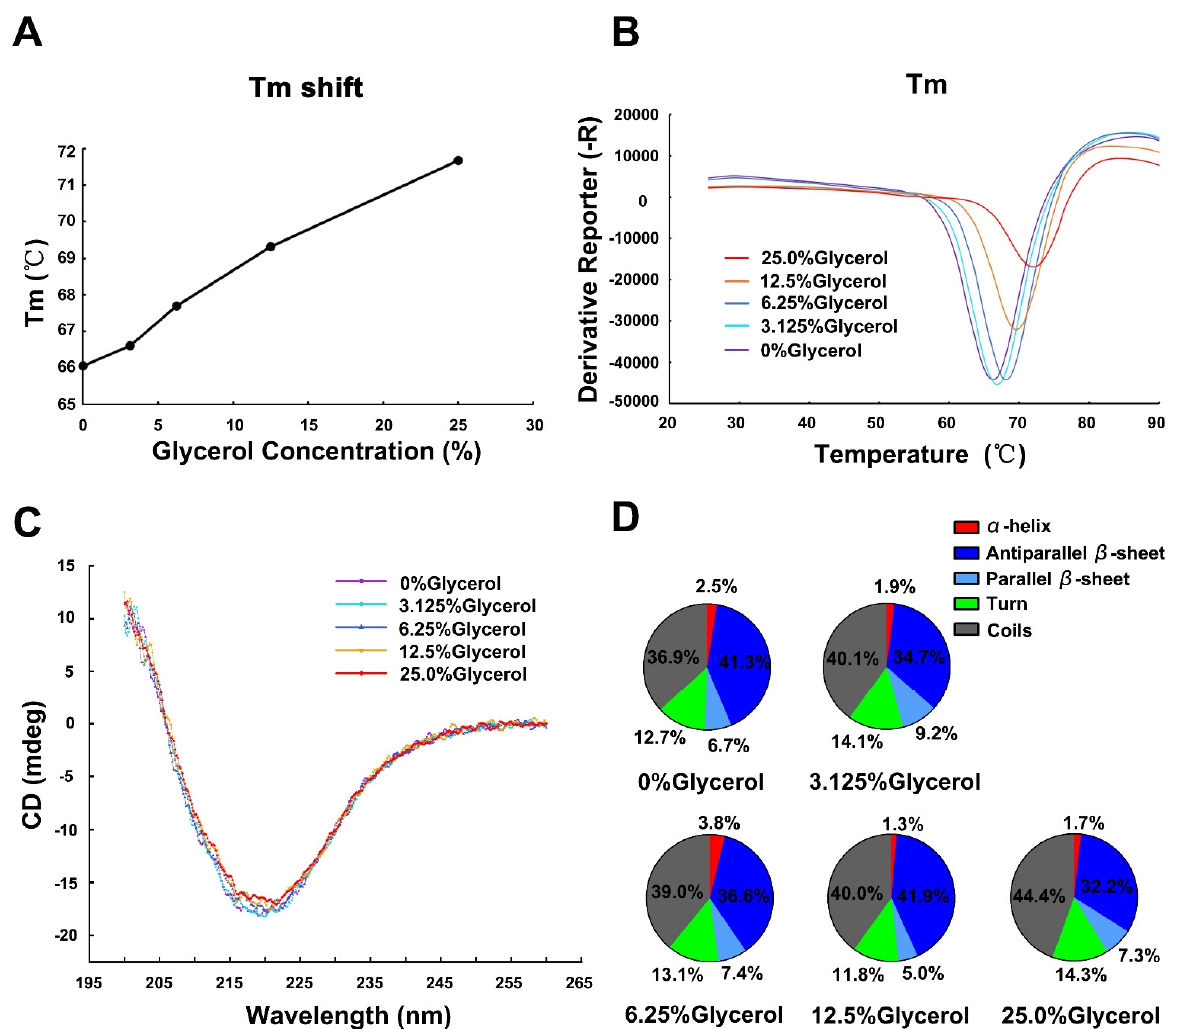
Figure 1. Thermal stability and secondary structural characteristics of Gal-7 in glycerol solutions. ( A ) Thermal shift assay. Tm shift when Gal-7 is incubated with different concentrations of glycerol. ( B ) Glycerol increases the melting temperature of Gal-7, indicating that glycerol can bind to Gal-7 and stabilize the structure of Gal-7. ( C ) CD assay. Profiles of CD spectrum of Gal-7 in glycerol solutions. The first negative derivative of the curve and CD spectrum of Gal-7 in 0%, 3.125%, 6.25%, 12.5%, and 25% glycerol are labeled purple, cyan, blue, yellow, and red, respectively. ( D ) Secondary structure content of human Gal-7 incubation with different concentrations of glycerol. The secondary